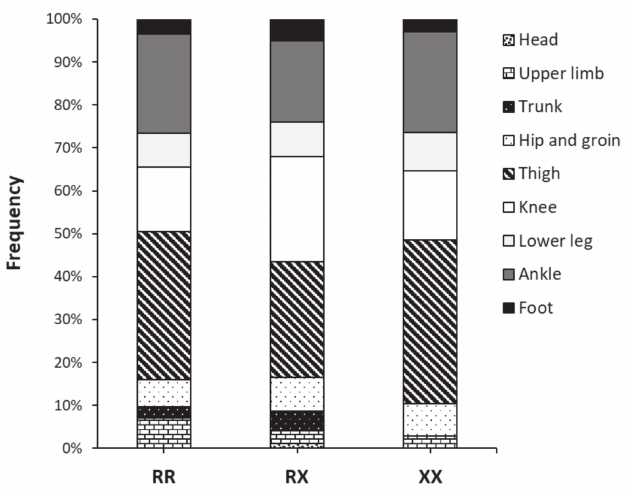
Figure 1. Distribution of non-contact injuries according to their body location in women football players of the first division of Spanish football with different ACTN3 R577X